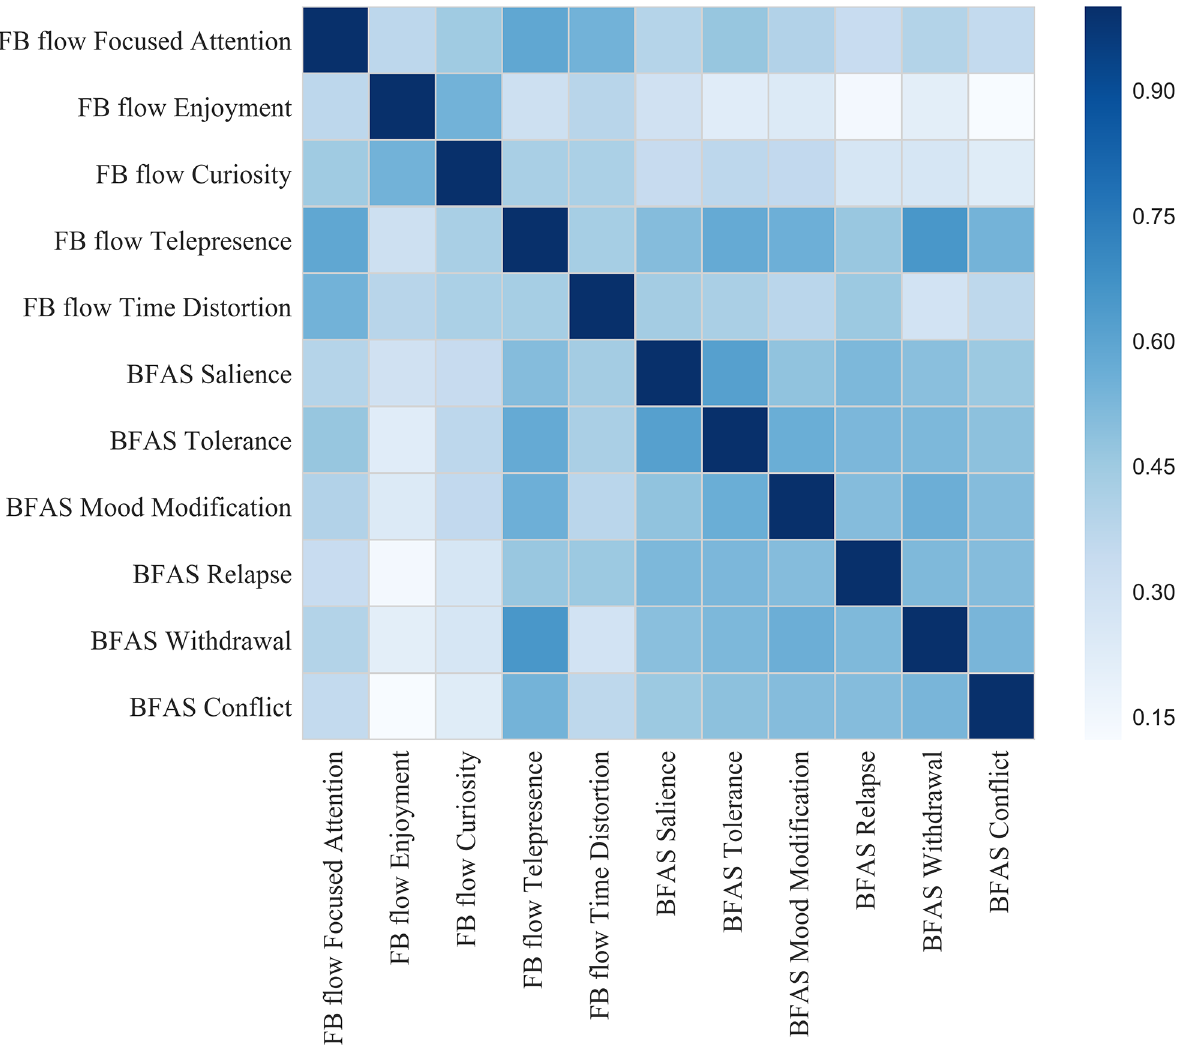
Fig 1. Correlogram of the correlations between the five FB flow subscales and the six FAD items (FB = Facebook; BFAS = Bergen Facebook Addiction